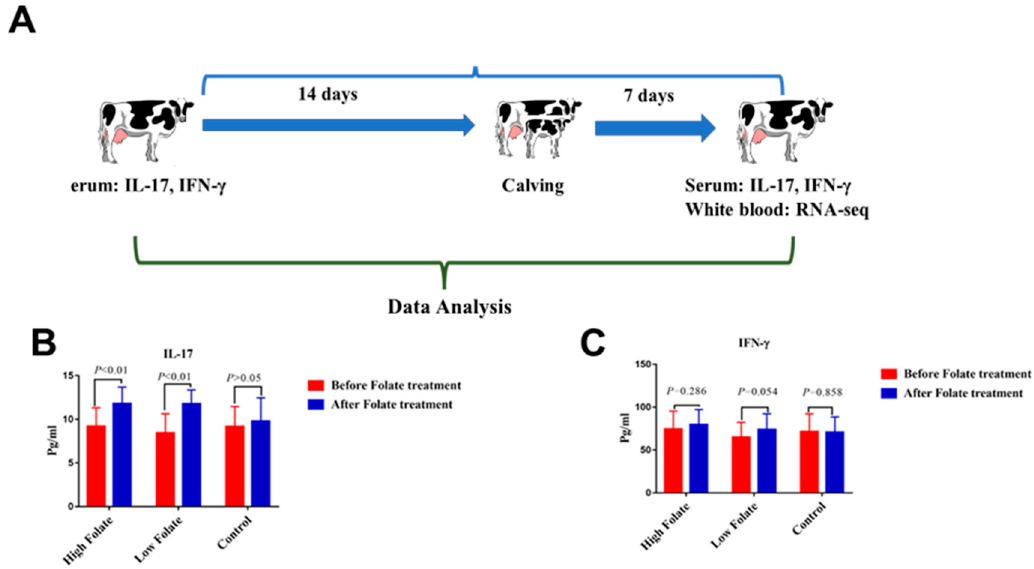
Figure 2. The influence of folic acid supplementation on serum cytokines of periparturient dairy cows [49]. ( A ) Experimental procedures of the entire study. ( B ) The level of IL-17 and ( C ) IFN- γ (pg / mL) in Holstein dairy cattle before and after folic acid supplementation. High folate (240 mg / 500 kg), low (120 mg / 500 kg body weight).